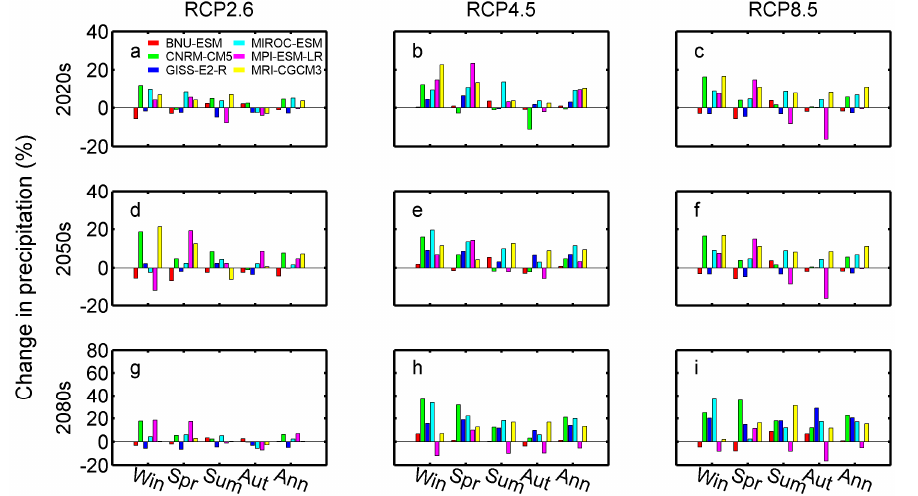
Figure 5. Changes in seasonal precipitation (%) in the future periods (2020s, 2050s and 2080s) under RCP 2.6, RCP 4.5 and RCP 8.5: ( a ) 2020s under RCP2.6; ( b ) 2020s under RCP4.5; ( c ) 2020s under RCP8.5; ( d ) 2050s under RCP 2.6; ( e ) 2050s under RCP4.5; ( f ) 2050s under RCP8.5; ( g ) 2080s under RCP2.6; ( h ) 2080s under RCP4.5; ( i ) 2080s under RCP8.5.